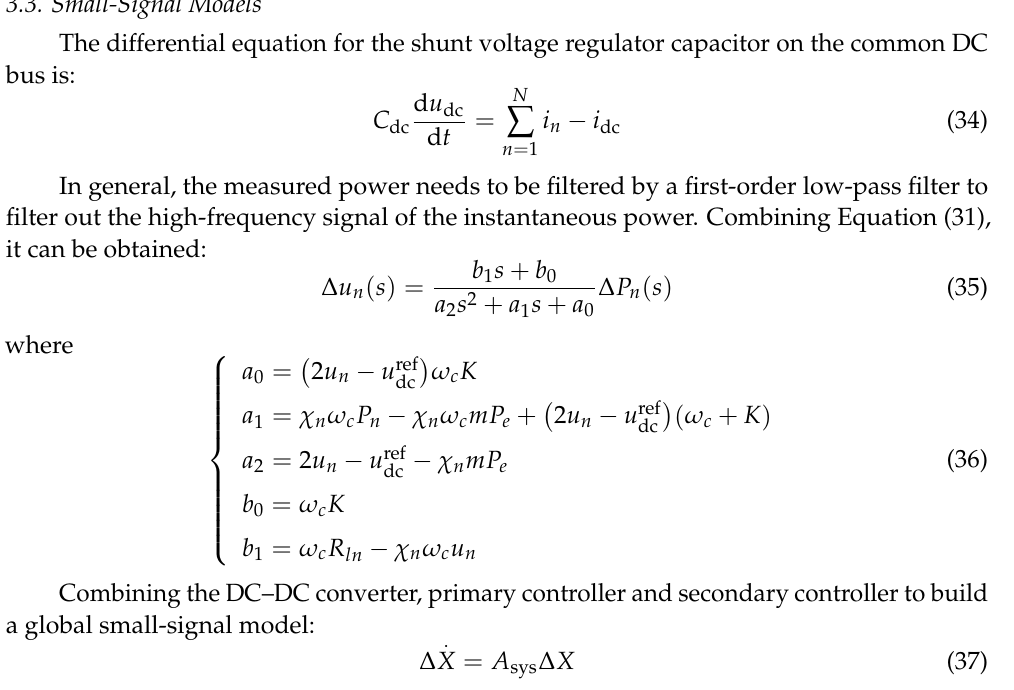
Figure 14. Overall control strategy for the DC microgrid considering the safety of the charging